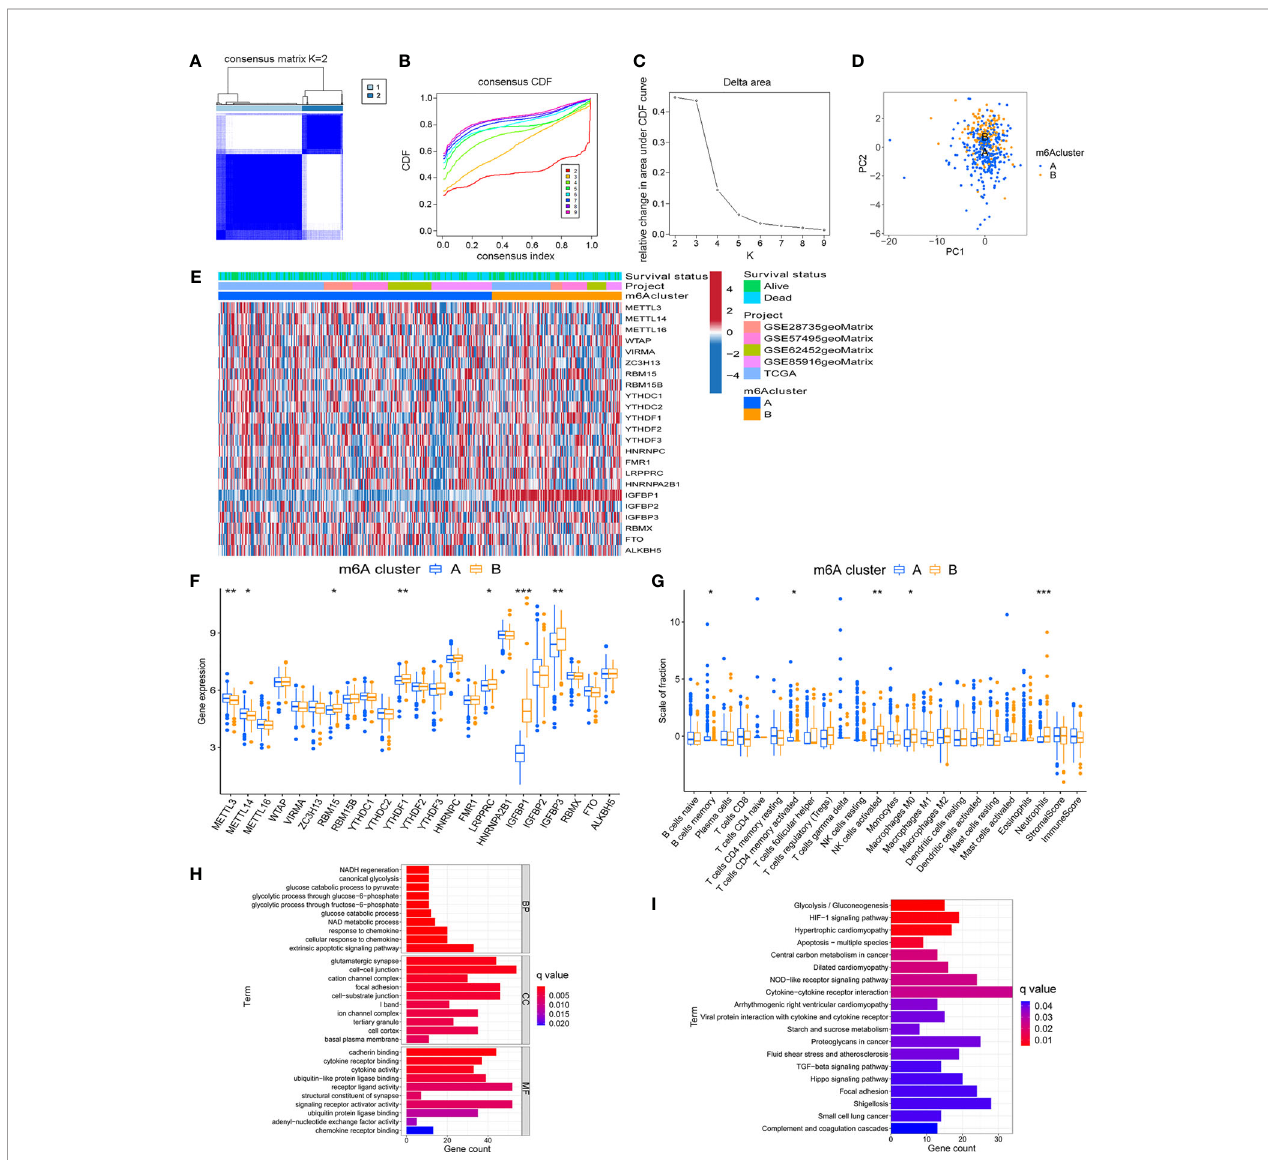
FIGURE 2 | Identi fi cation of m 6 A methylation modi fi cation subtypes. (A) Heat map of sample clustering under k = 2 in 5 independent PC cohorts. (B) Consensus clustering cumulative distribution function (CDF) with the number of subtypes k = 2 to 9. (C) The relative change of the area under the CDF curve of k = 2 to 9. (D) Principal component analysis of the expression pro fi les of 23 m 6 A regulators to distinguish two determined m 6 A clusters. (E) Unsupervised clustering of 23 m 6 A regulators in two m 6 A clusters. (F) Differences in the expression of 23 m 6 A regulators between distinct m 6 A clusters. (G) TME immune-in fi ltrating characteristics and transcriptome traits of two m 6 A clusters. (H) GO enrichment pathway of differentially expressed genes between two m 6 A clusters. (I) KEGG enrichment pathway of differentially expressed genes between two m 6 A clusters. ***P < 0.001; **P < 0.01; *P <